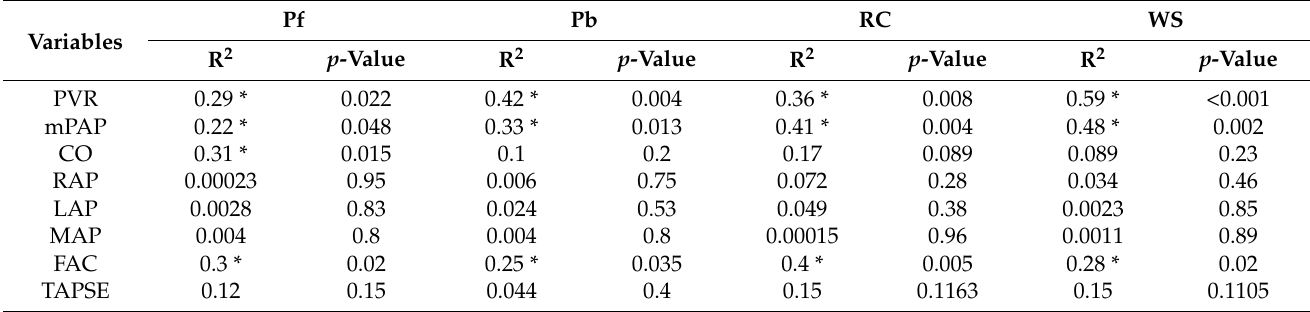
Table 3. Effect of PAWR indices on hemodynamic and echocardiographic